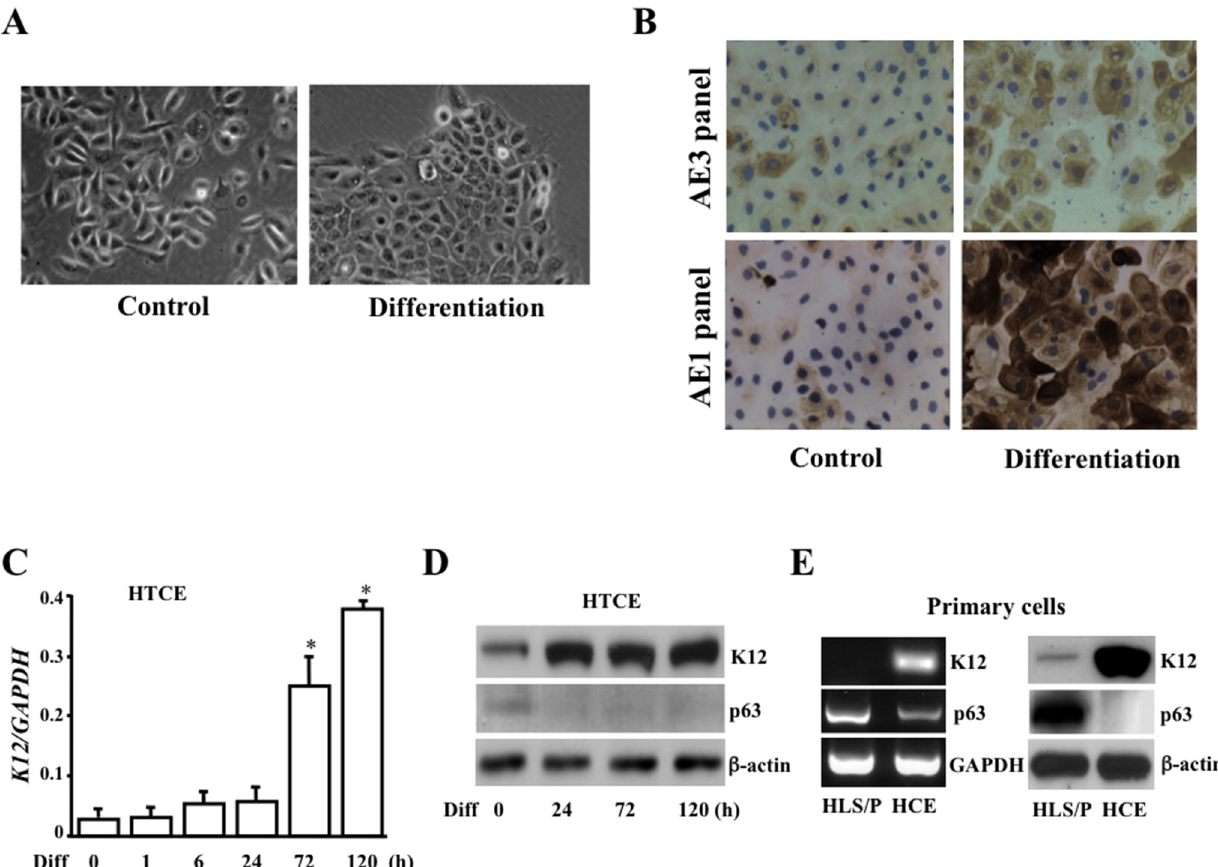
Fig 1. Characterization of differentiation-induced corneal epithelial cells. ( A ) Morphological changes in culture during differentiation of HTCE cells. ( B ) AE3 and AE1 keratin panel staining in HTCE cell differentiation. ( C ) Time course of K12 mRNA expression following induced differentiation of HTCE cells. Differentiation of HTCE cells was induced by adding 1.2 mM calcium and 5% FBS in the normal culture condition up to 120 h. ( D ) Detection of K12 and p63 expression in HTCE cell differentiation by Western blot up to 120 h. ( E ) Expression of K12 and p63 mRNAs and proteins in human limbal stem/progenitor (HLS/P) and corneal epithelial (HCE) cells. Cells were grown and induced to differentiation in chamber slides and photos were taken by light microscopy. These cells were then washed in PBS and fixed with 95% ethanol before staining. Staining protocols were used as suggested by manufactures. Furthermore, RNAs were extracted from HTCE, HLS/P and HCE cells, and reverse-transcribed into cDNAs before real-time qPCR analysis was performed using K12-specific primers as indicated in Materials and Methods. Symbol “ * ” indicates significant differences after 72 h induction ( p < 0.05, n = 6). Photos were taken by a Zeiss AXIO microscope